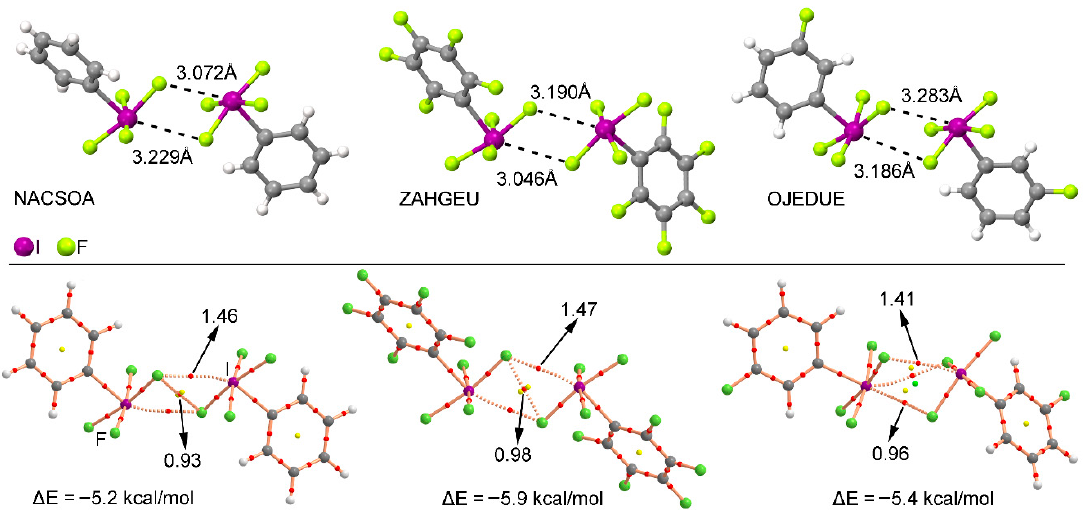
Figure 6. ( Top ) Partial views of the X-ray structure of some multivalent iodine derivatives establishing halogen bonding interactions. The CSD codes are indicated. ( Bottom ) AIM analysis of NACSOA, ZAHGEU, and OJEDUE structures at the MP2/def2-TZVP level of theory. Bond and ring CPs are represented by red, yellow, and green spheres, respectively. The values of the charge density (10 2 x ρ ) at the bond critical points that emerge upon complexation are indicated in a.u.